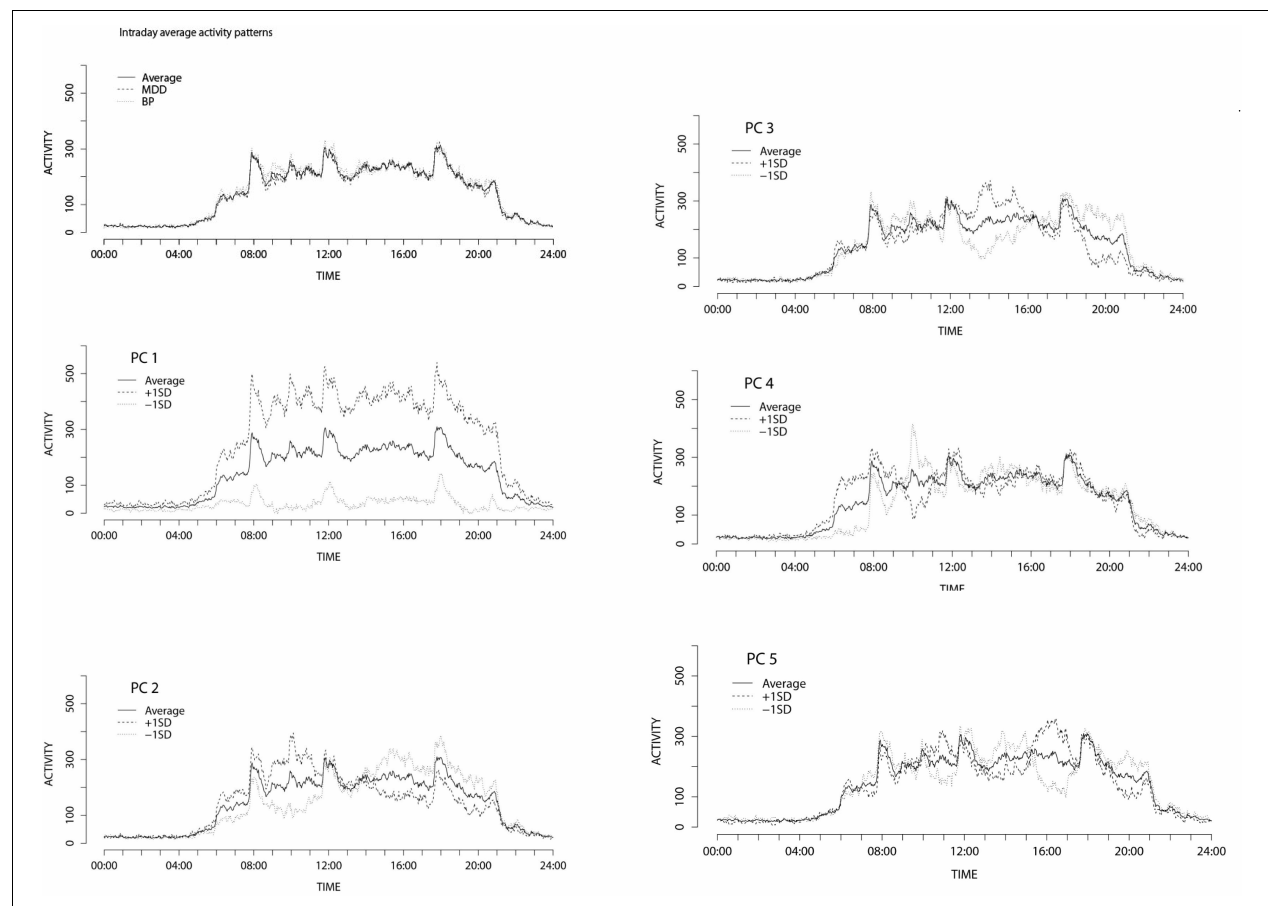
FIGURE 2 | Intraday average activity patterns and Activity patterns ± 1SD variation along the principal components of intraday